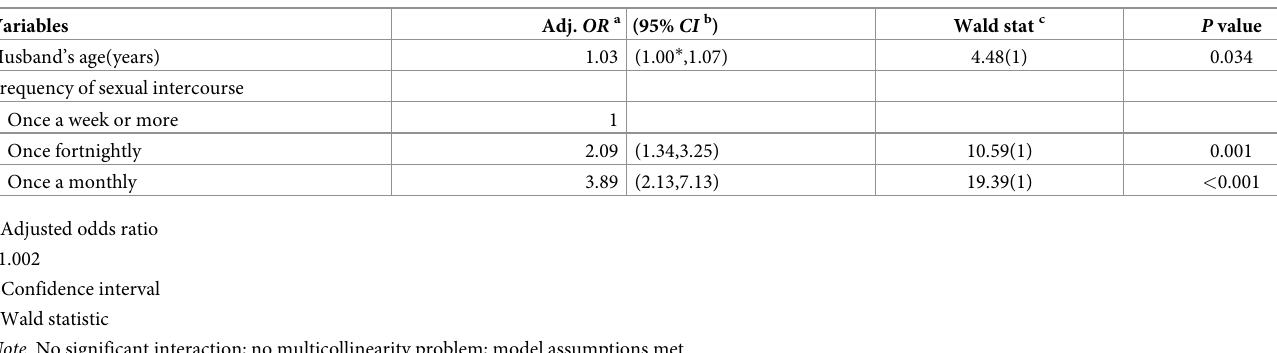
Table 4. Associated factors for female sexual dysfunction using multivariate logistic